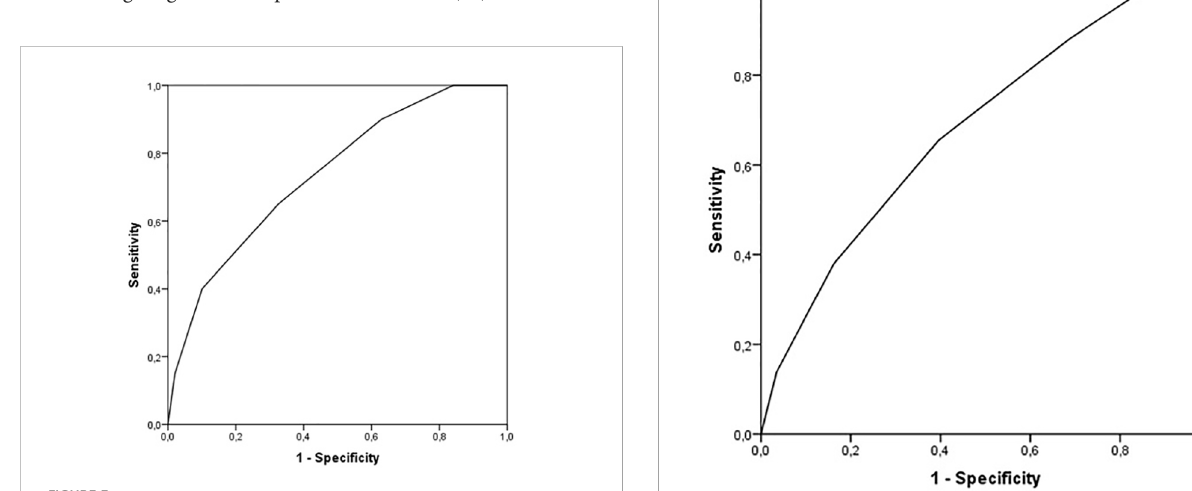
FIGURE 3 Receiver operating characteristic curve of CSA-CKD score for CKD. CSA-CKD, Cardiac surgery associated chronic kidney disease; CKD, chronic kidney disease.